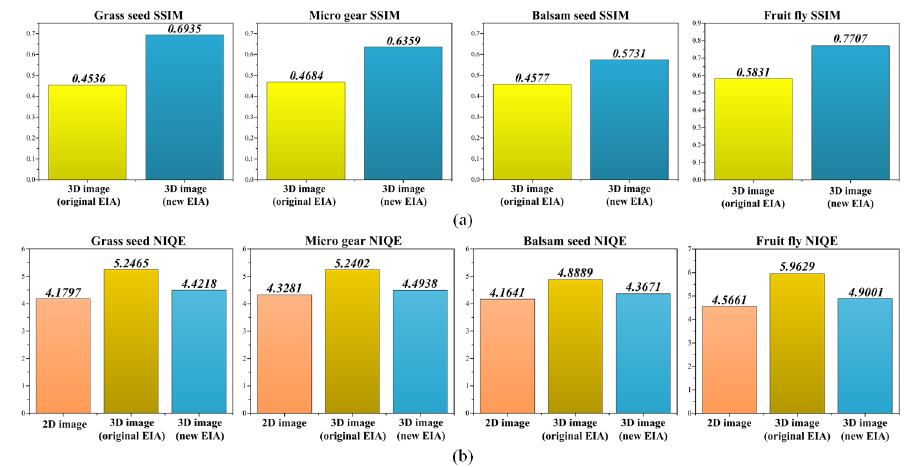
Figure 15. Quantitative evaluation result for comparison; ( a ) SSIM graph, ( b ) NIQE